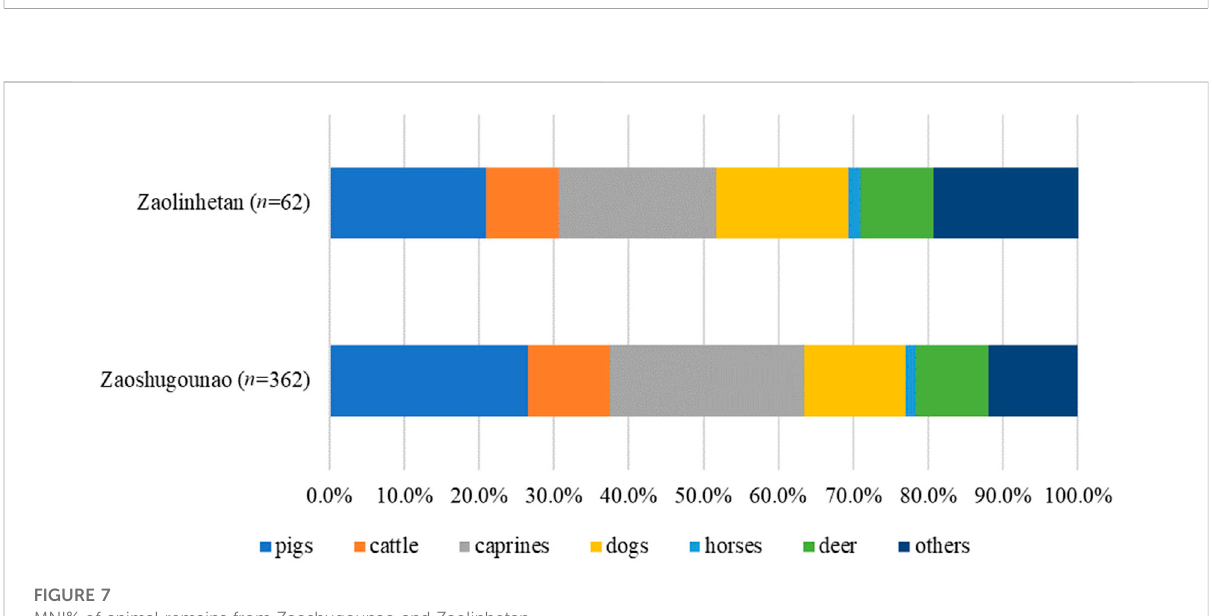
FIGURE 7 MNI% of animal remains from Zaoshugounao and